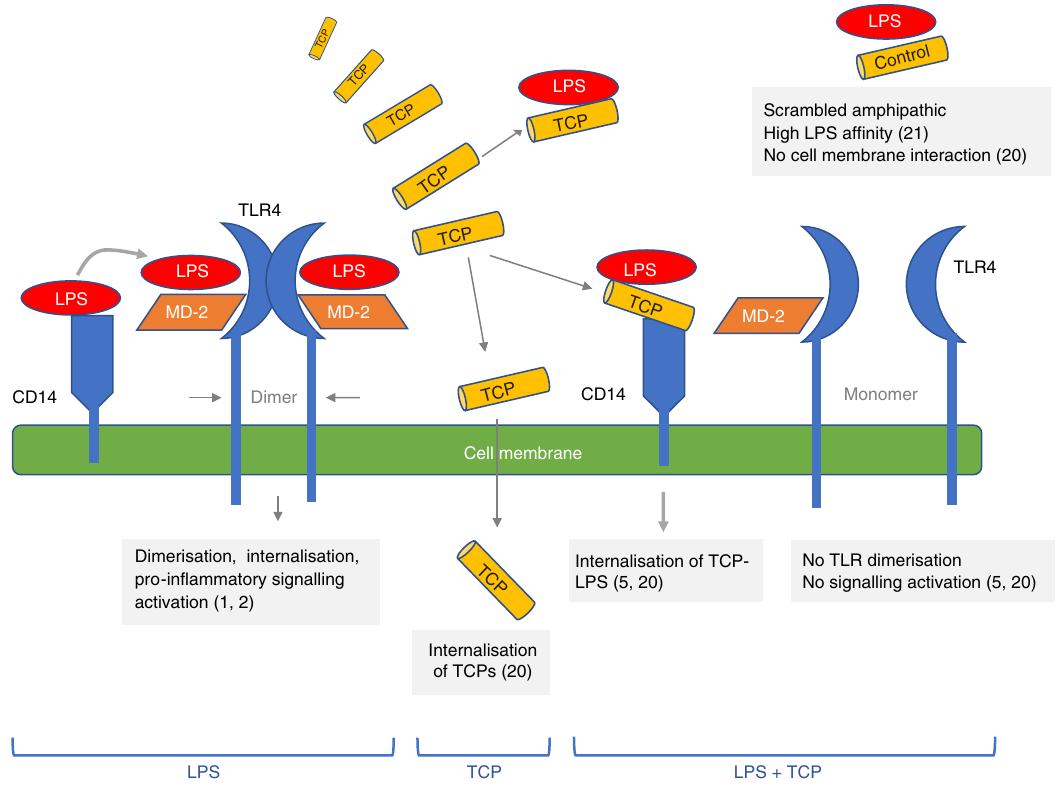
Fig. 7 The multiple effects of TCPs. TCPs exert anti-in fl ammatory effects and protect from endotoxic shock and bacterial sepsis in experimental animal models 5,7,8,22 . Binding of the TCP HVF18 to LPS leads to a structural transition, wherein the peptide forms a C-shaped structure comprising a C-terminal helix, and serves in LPS scavenging and bacterial cell neutralisation. TCPs not only interact with bacteria and LPS, but also directly with monocytes/ macrophages, leading to interference with TLR4 dimerization 20 as well as to CD14 ( K d ~ μ M levels) on monocytes and macrophages, and may be subsequently internalised. This is proposed to competitively block CD14 – LPS interaction, and/or to prevent transfer of LPS to the TLR4/MD-2 complex, thus interfering with TLR4 dimerisation and downstream in fl ammatory responses 47 . This effect is abrogated in a scrambled, amphipathic TCP sequence, which retains af fi nity for LPS but demonstrates no anti-endotoxic